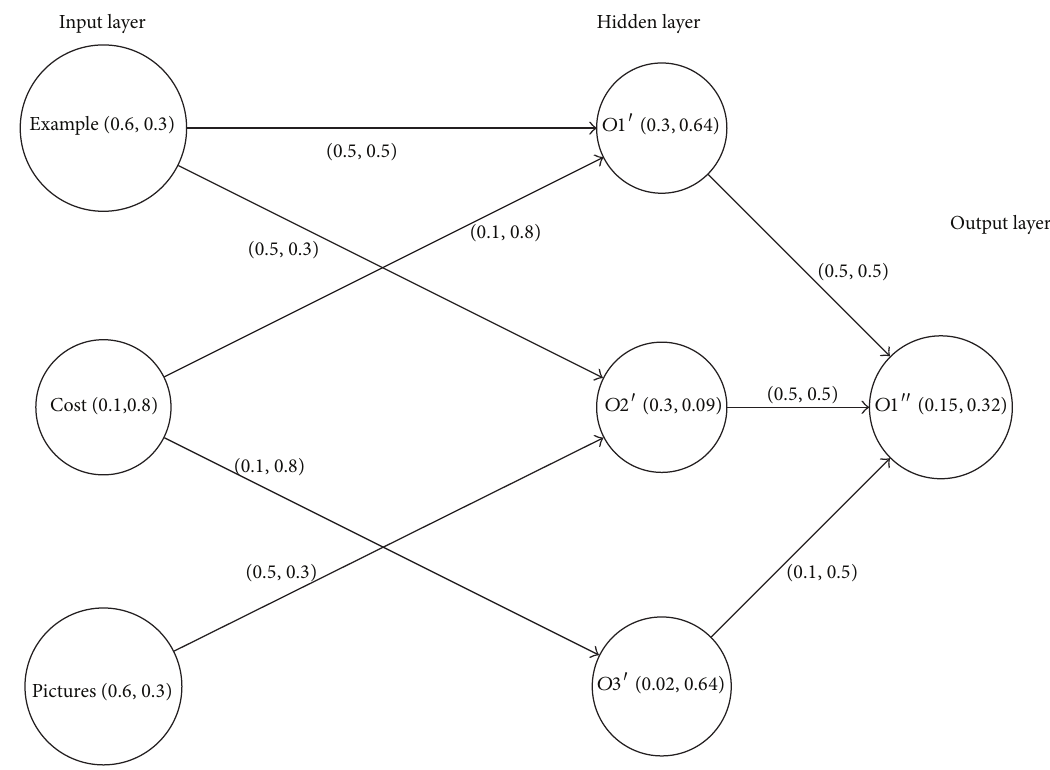
Figure 3: Intuitionistic fuzzy digraph of marketability.